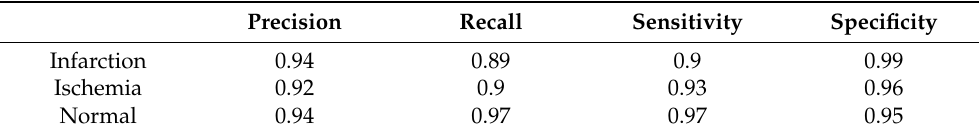
Table 2. Presentation of values of efficient metrics of best RGB-CNN model for each class.